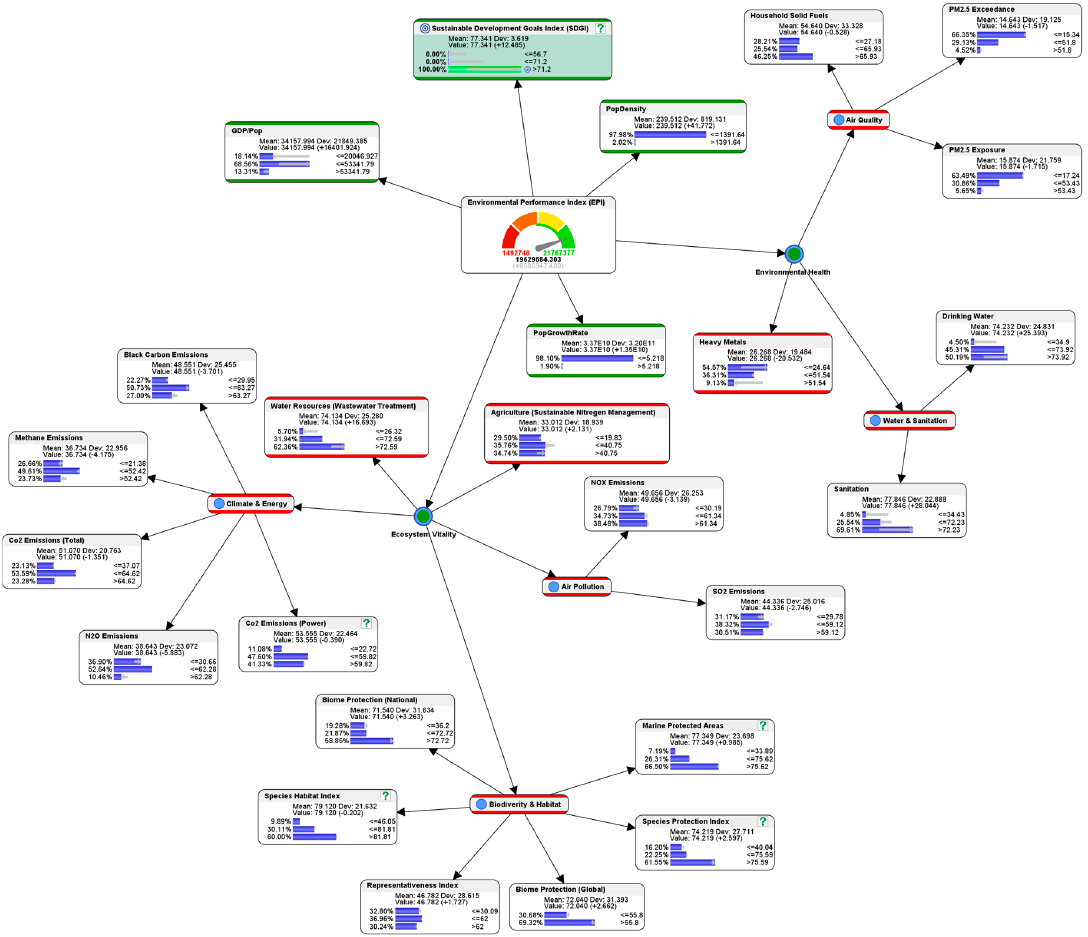
Figure 6. Example of a best-case scenario. Table 3. Results of predictive analysis of the best-case scenario.